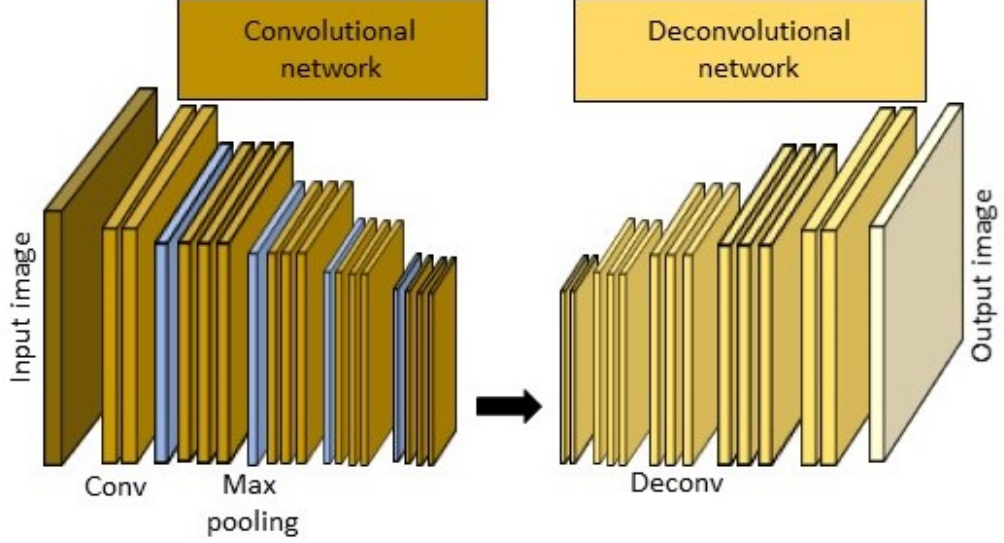
Figure 5. General architecture of deconvolutional networks.